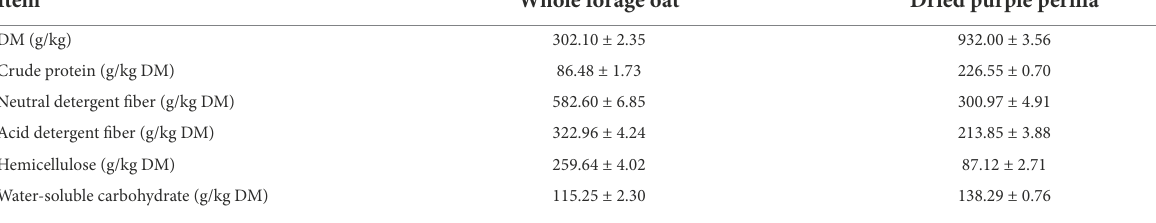
TABLE 1 Chemical composition of raw